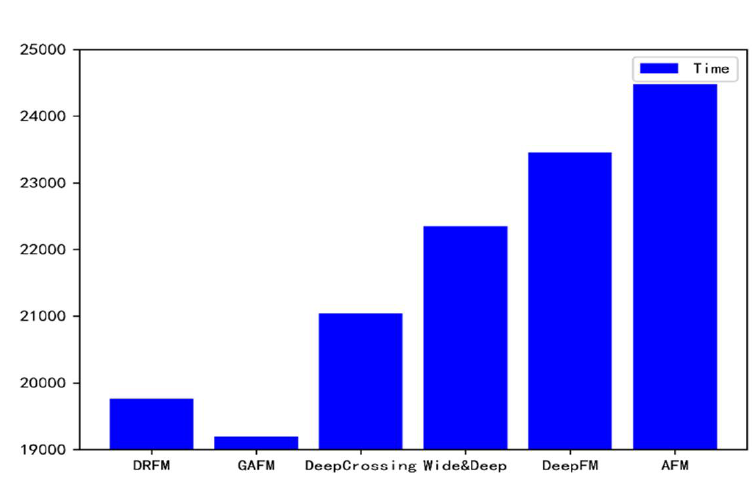
Figure 12. Running time of each model on dataset 3.